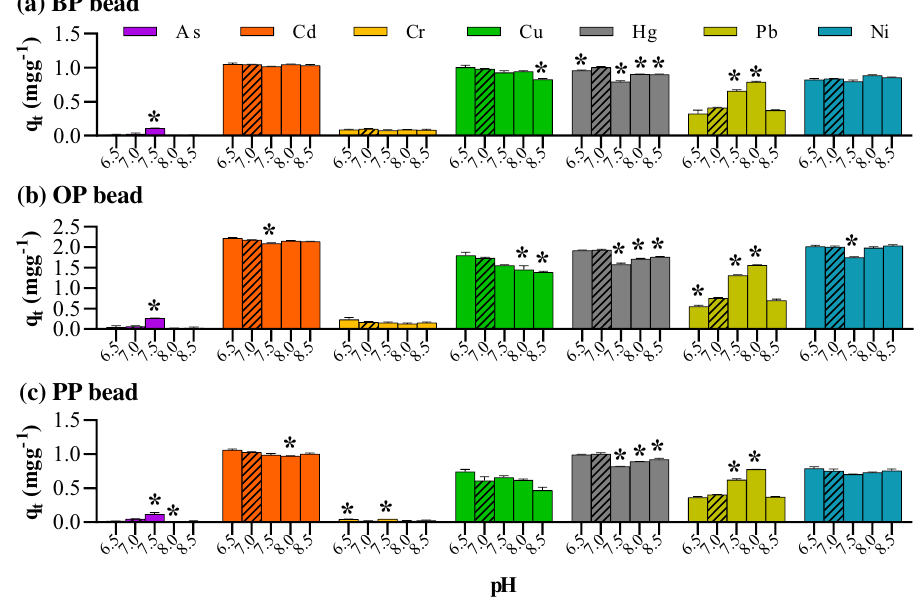
Fig. 3 Effect of pH on bead biosorption capacity. One bead was incubated in a cocktail solution of all seven ions each at 0.1 mgL-1, 25 °C with continu- ous shaking at 250 rpm for 24 h. The initial pH of each solution was adjusted to the specified pH at the start of the experiment. The points represent mean ± SE for N = 3. Statistical significance was calculated based on a one- way ANOVA with Bonferroni post hoc test, *Significantly different compared to pH 7.0, p < 0.05. a BP bead, b OP bead and c PP